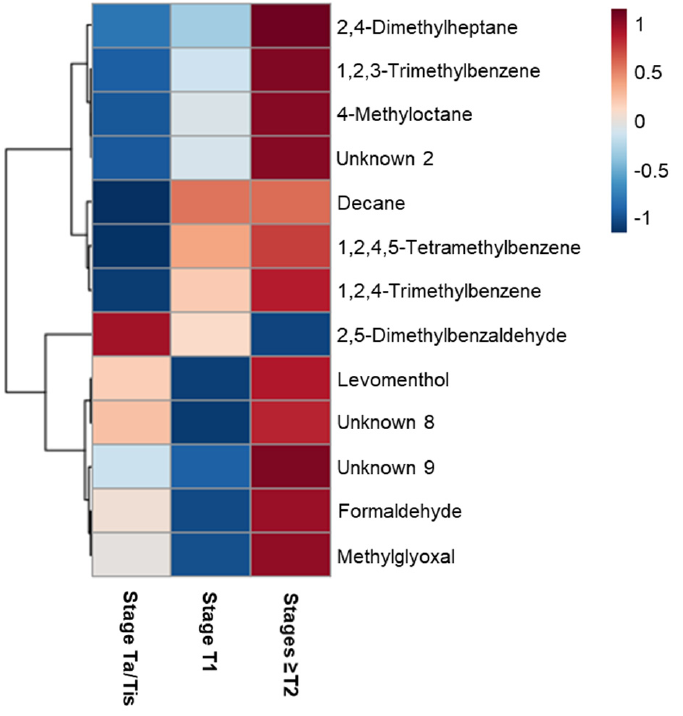
Figure 3. Heatmap illustrating the levels of urinary volatile metabolites changing between NMIBC (stage Ta/Tis and T1) and MIBC (stages ≥ T2) patients. Columns correspond to each sample group, while rows correspond to the mean normalized peak area of each discriminant volatile metabolite colored from minimum ( − 1, dark blue) to maximum (1, dark red).